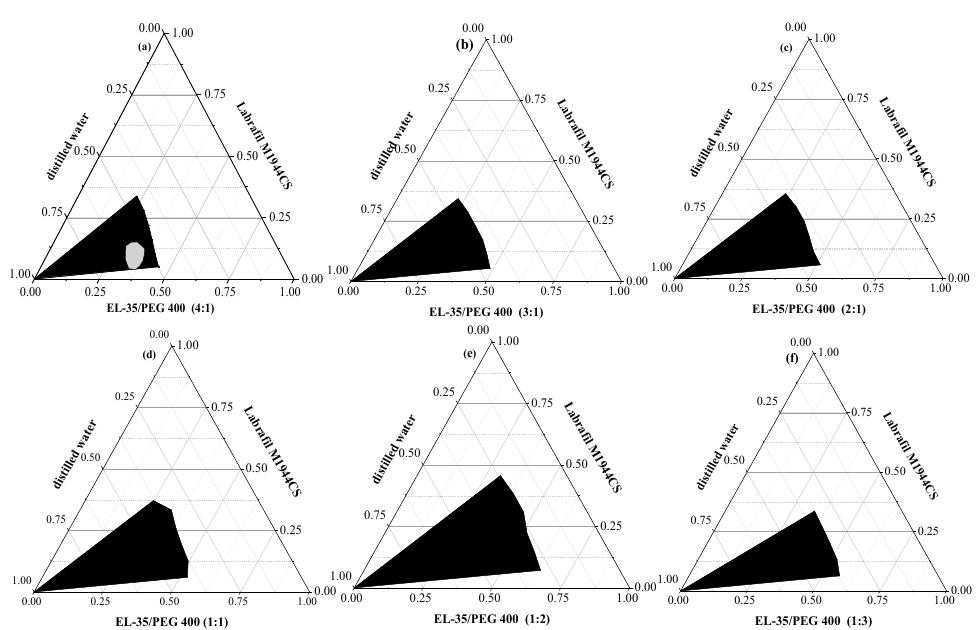
Figure 2. Pseudo-ternary phase diagram of different Km. EL-35:PEG-400 (4:1) ( a ), EL-35:PEG-400 (3:1) ( b ), EL-35:PEG-400 (2:1) ( c ), EL-35:PEG-400 (1:1) ( d ), EL-35:PEG-400 (1:2) ( e ), and EL-35:PEG-400 (1:3) ( f ). The black area represents the microemulsion region, the white area represents the coarse emulsion region, and the grey area represents the gel-like region.